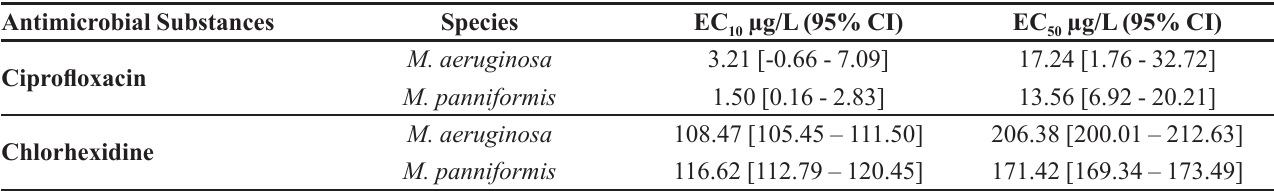
: effective concentration leading to 10% inhibition of species growth. EC EC 10 of species growth. CI: confidence